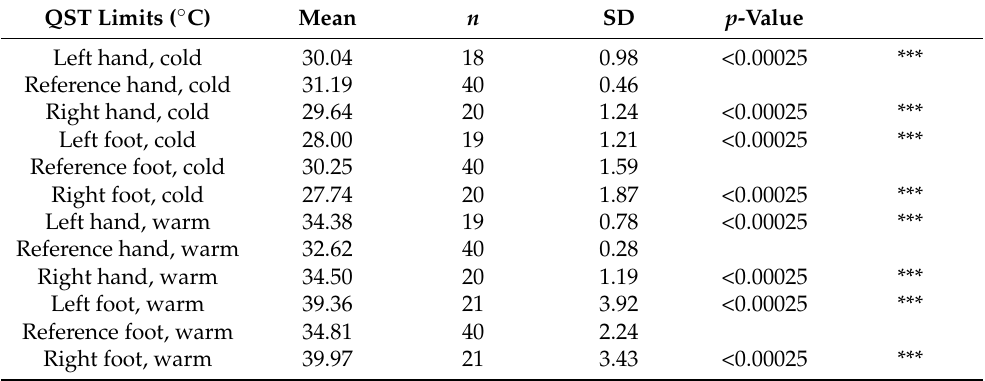
Table 1. QST limit values for cold and warm sensations on the palm of the hand and arch of the foot. Reference values derived from manufacturers published data from healthy subject normative data. SD is standard deviation. *** indicates a statistically significant difference to reference material with p -values corresponding to Bonferroni corrected